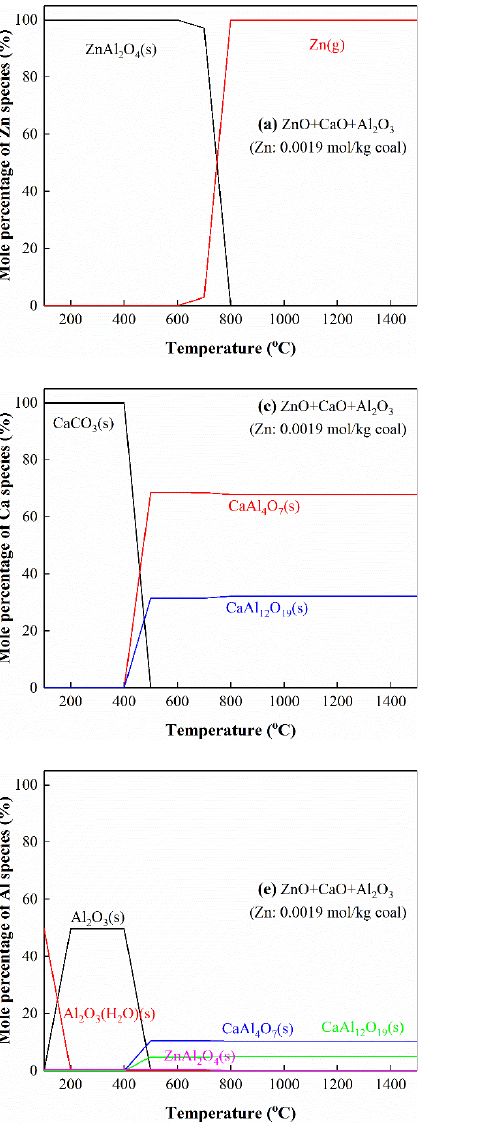
Figure 13. Thermodynamic equilibrium distributions of Zn ( a , b ), Ca ( c , d ) and Al ( e , f ) when Zn, Ca and Al coexist in the coal. 3.5.8. The Interactions of Zn with S, Ca, Al, Si and Fe